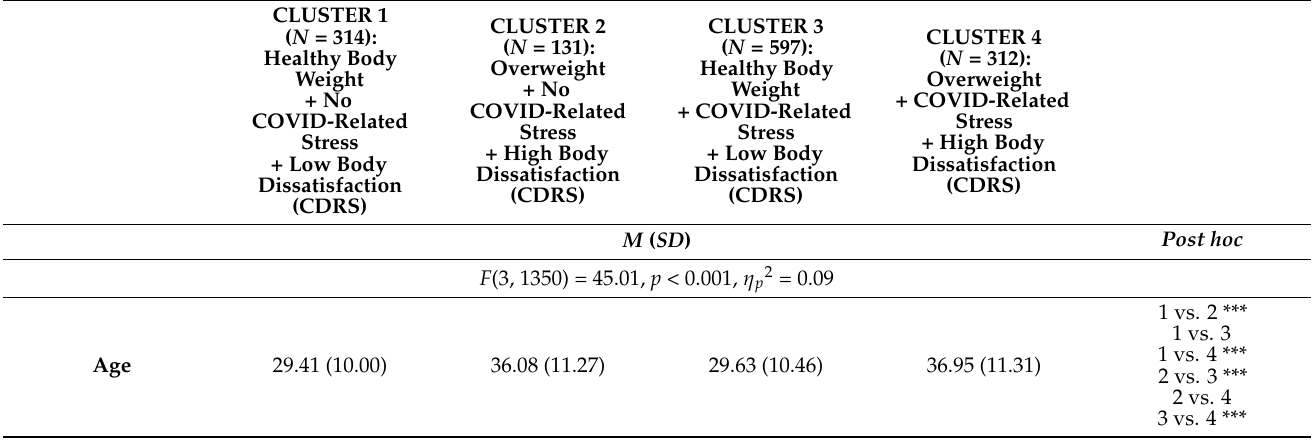
Table 1. Between-cluster differences: age, body mass index, emotional overeating, eating motives, and mindful eating. CLUSTER 1 ( N =